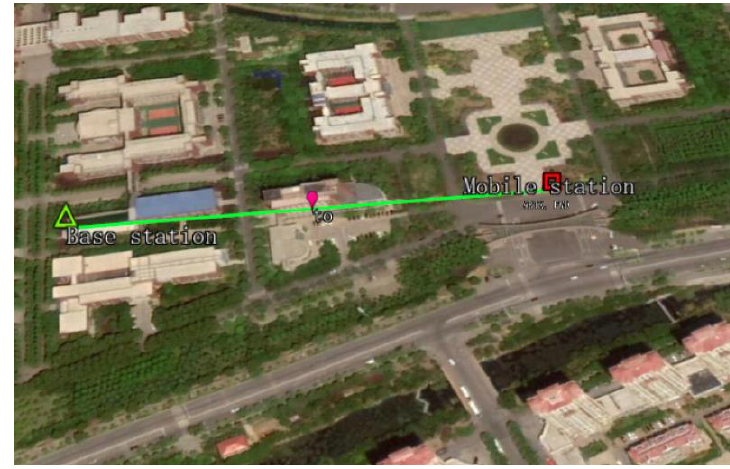
Figure 3. The environment of the static experiment.